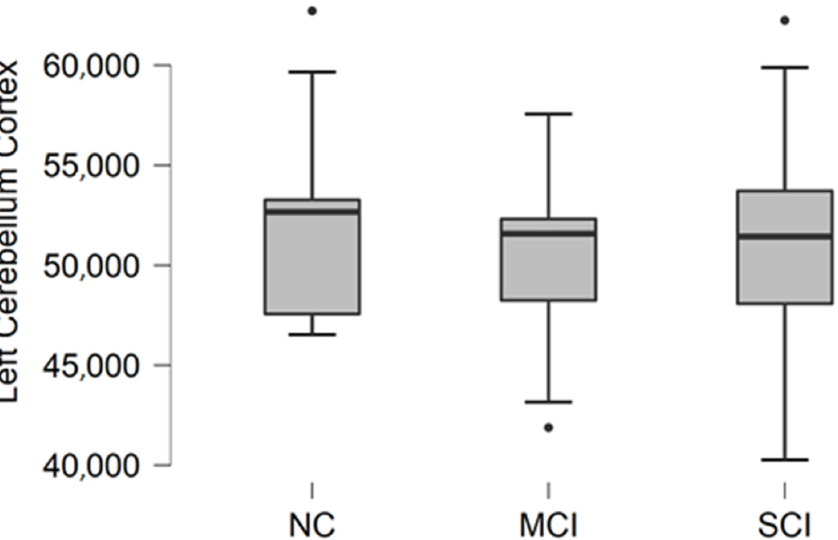
Figure 2. Mean left cerebellum cortex volume in mm 3 with standard deviation in participant groups. Black dots represent outliers (i.e., exceptionally diverging values). Table 4. Descriptive statistics for right cerebellum white matter volume in participants with normal cognition (NC), mild cognitive impairment (MCI), and moderate/severe cognitive impairment (SCI).